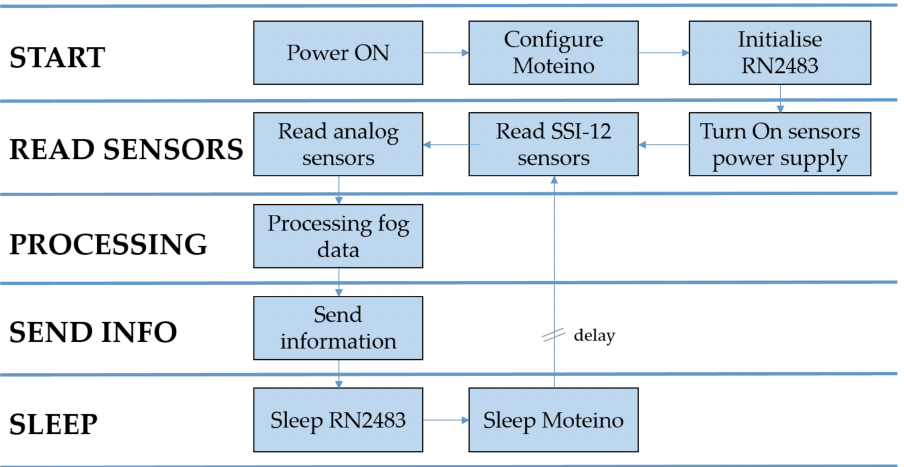
Figure 3. Flow chart of the node